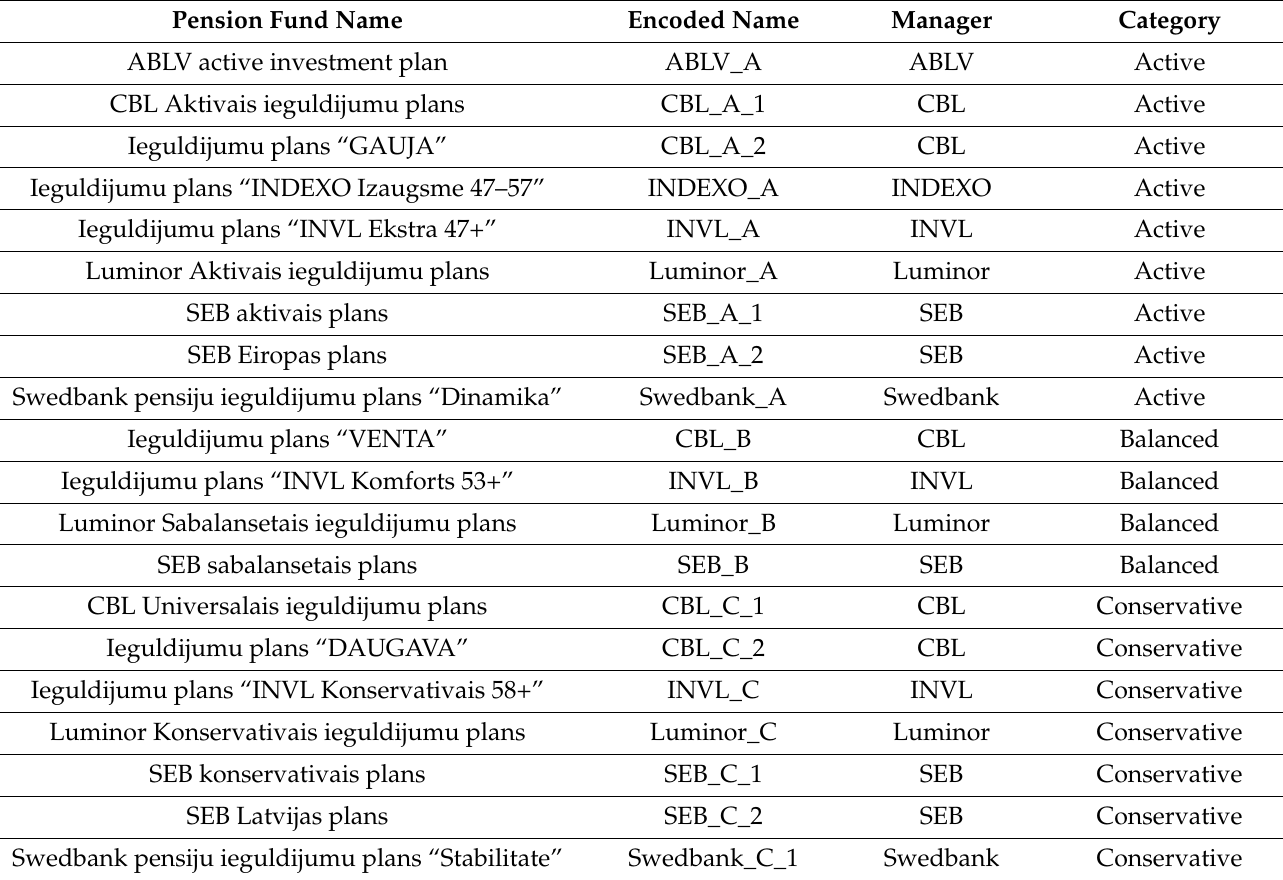
Table 1. Pension fund names, pension fund name encodings, management company, and risk category to which they